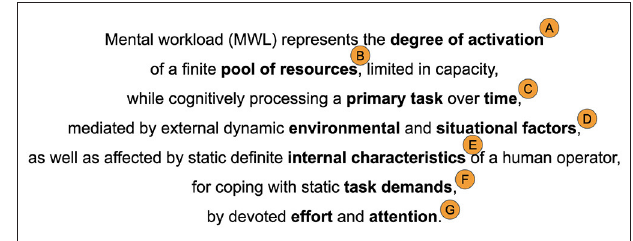
FIGURE 15 | A novel, inclusive and operational definition of human mental workload.